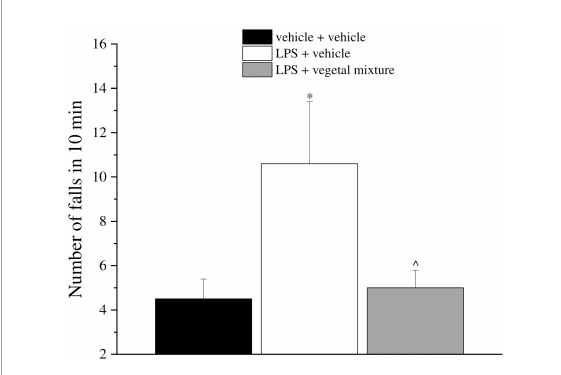
FIGURE2 Effect of a vegetal mixture on LPS-induced motor alterations. LPS (1 mg kg - 1 ) was intraperitoneally injected on days 1, 3, 5, and 8. The vegetal mixture was composed of Zingiber officinale (150 mg kg - 1 ), Echinacea purpurea (20 mg kg - 1 ), and Centella asiatica (200 mg kg - 1 ), suspended in 1% carboxymethylcellulose sodium salt (CMC) and orally administered daily starting from